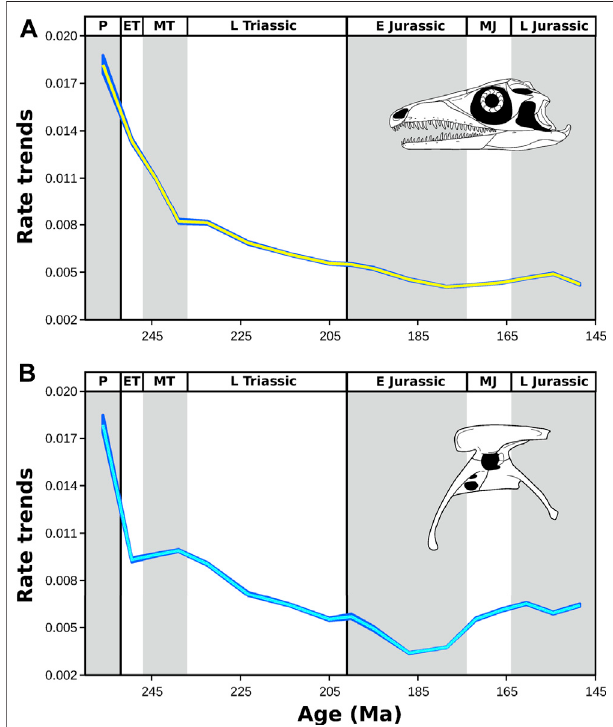
FIGURE12| Change throughtimeofevolutionaryratesof2D geometric morphometric shape in the archosauromorph cranium (A) and pelvis (B) from the late Permian to Late Jurassic. Rates were initially very high and dropped across the interval. The yellow (cranium) and cyan (pelvic) lines show the median of rate for all branches crossing each bin, with the blue band surrounding it indicating the 95% con fi dence interval based on 1,000 range calibrated trees. Prolacerta skull (A) modi fi ed after Ezcurra (2016); Coelophysis pelvis (B) modi fi ed after Tykoski (2005). Abbreviations: P, Permian; ET, Early Triassic; MT Middle Triassic L Triassic, Late Triassic; E Jurassic, Early Jurassic; MJ, Middle Jurassic; L Jurassic, Late Jurassic ( Supplementary Material S1-Tables S4 – S6